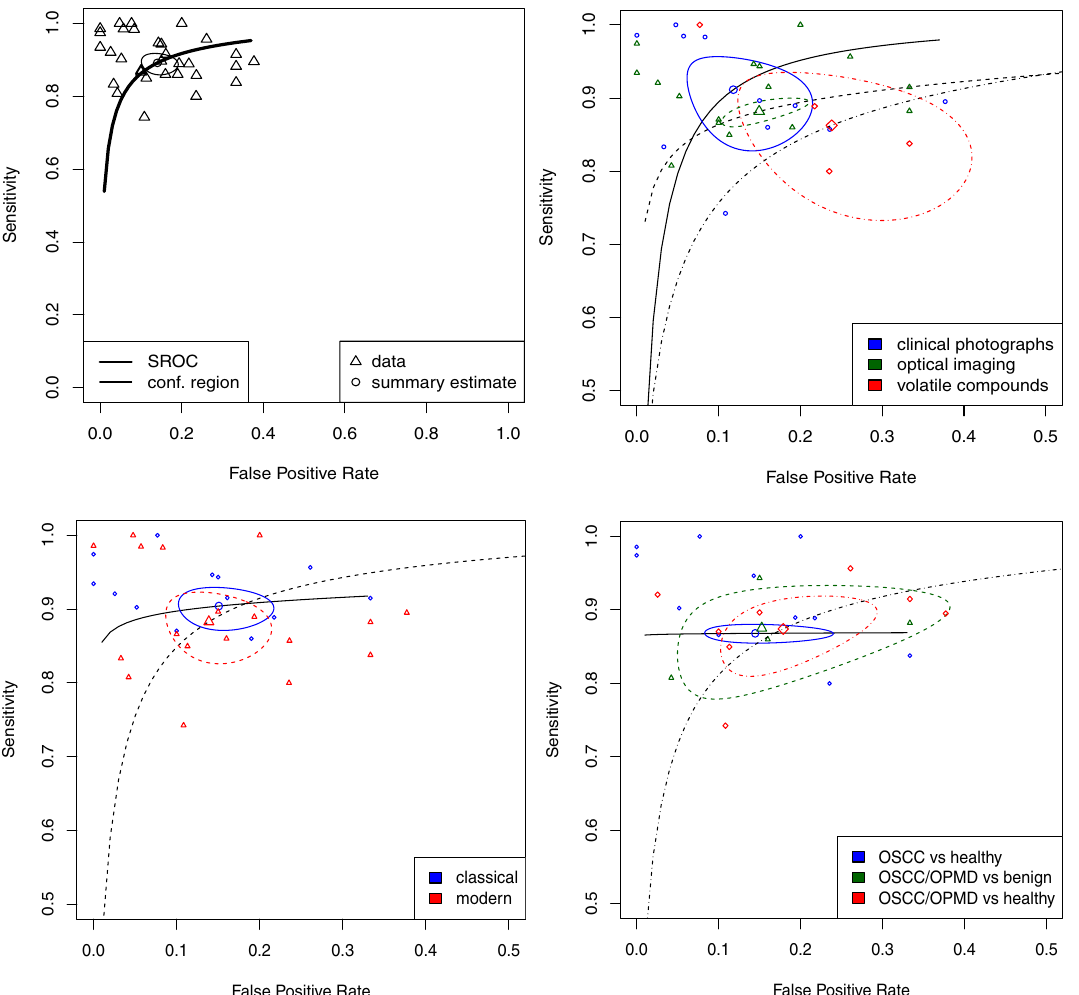
Figure 3. Summary Receiver Operator Characteristic (sROC) curves to estimate model performance; Top left, sROC curve of bivariate model of all studies (AUC 0.935); top right, sROC curves according to methodology; bottom left, sROC curves according to AI type; bottom right, sROC curves according to lesion type. AUC for subgroups, and results of subgroup analysis are provided in Table